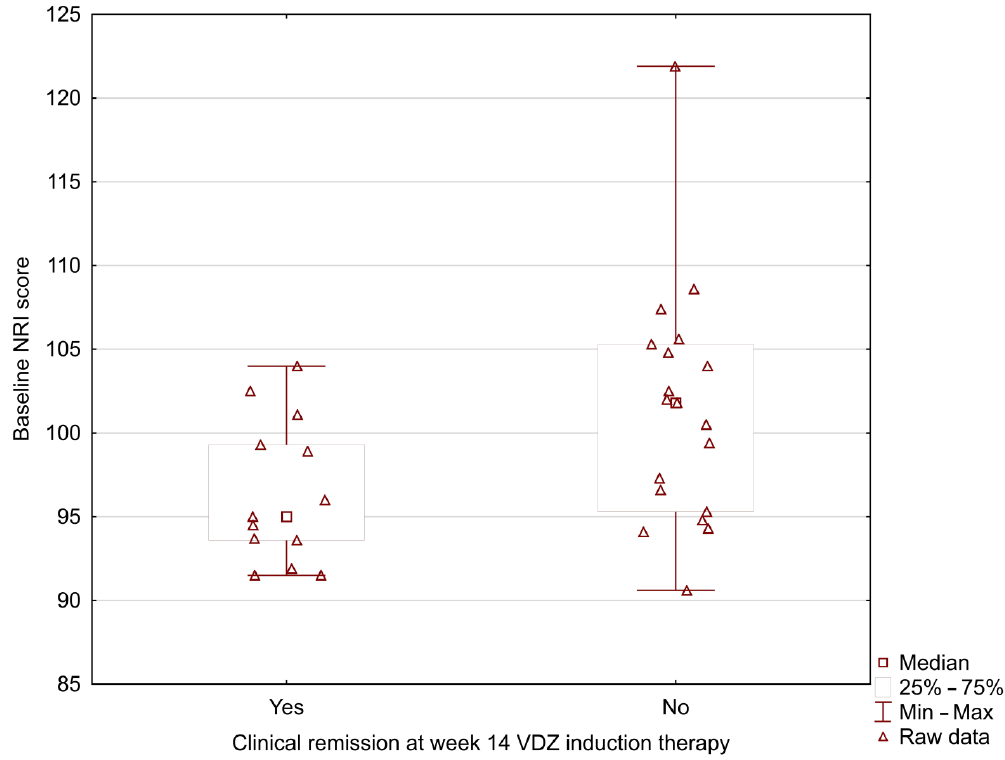
Figure 2. Relationship between the baseline NRI score and clinical remission at week 14 during vedolizumab induction therapy (96.42 ± 4.29 vs. 101.41 ± 7.09; p = 0.024).